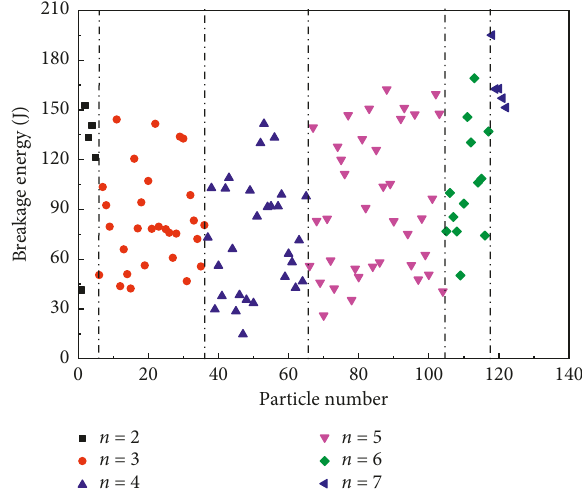
Figure 9: Breakage energy of each particle.